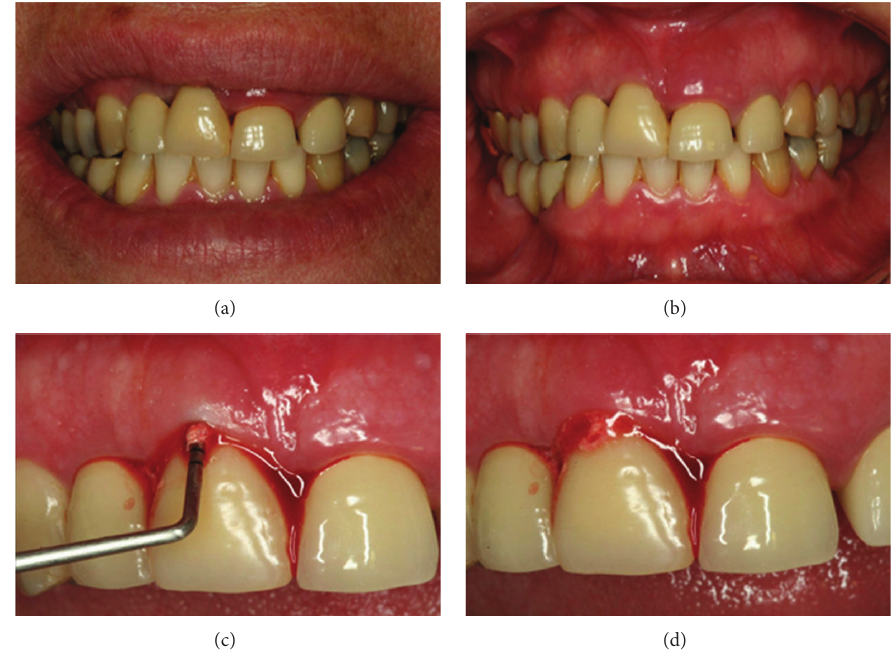
Figure 1: A 57-year-old female presented with an implant-supported provisional restoration on the maxillary right central incisor. (a, b) Image showed the uneven level of the gingiva of the maxillary anterior teeth. (c) Clinical examination showing abscess in the right maxillary central incisor region. (d) Cement retention of the implant-supported prosthesis.